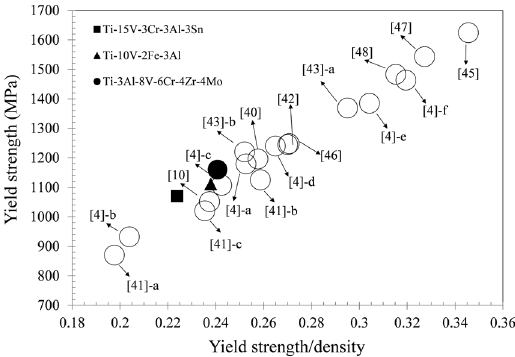
Figure 3. Chart plotting the yield strength versus specific strength of titanium alloys shown in Tab. 1. The data from the CES Edupack 2009 software for the Ti-15V-3Cr-3Sn-3Al, Ti-3Al-8V-6Cr-4Zr-4Mo and Ti-10V-2Fe-3Al alloys (Fig. 2) are also shown for comparison. Each circle represents a titanium alloy at a specific condition. The numbers in square brackets represent the references from which the data were taken, which are also displayed in Tab.